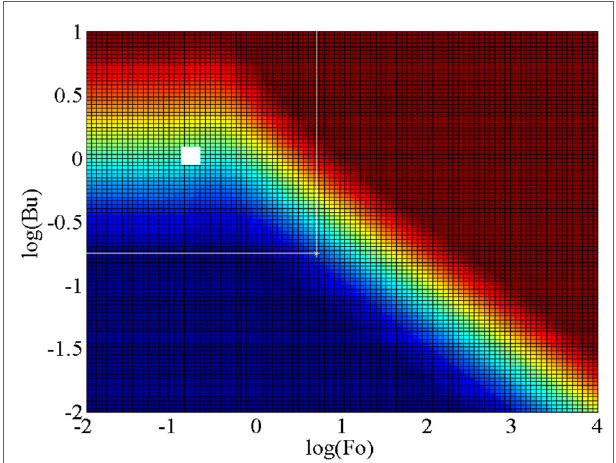
FiGURe 10 | Map of conjugation in Fo–Bu space, showing the extent of conjugation in unsteady 1D solid–fluid systems, with an isoflux outer wall boundary condition . Red indicates large temperature fluctuations and small heat-flux fluctuations (approaching an isoflux boundary condition) on the inner wall surface at the (wetted) solid–fluid interface, and blue indicates large heat-flux fluctuations and small temperature fluctuations on the inner wall surface (approaching an isothermal boundary